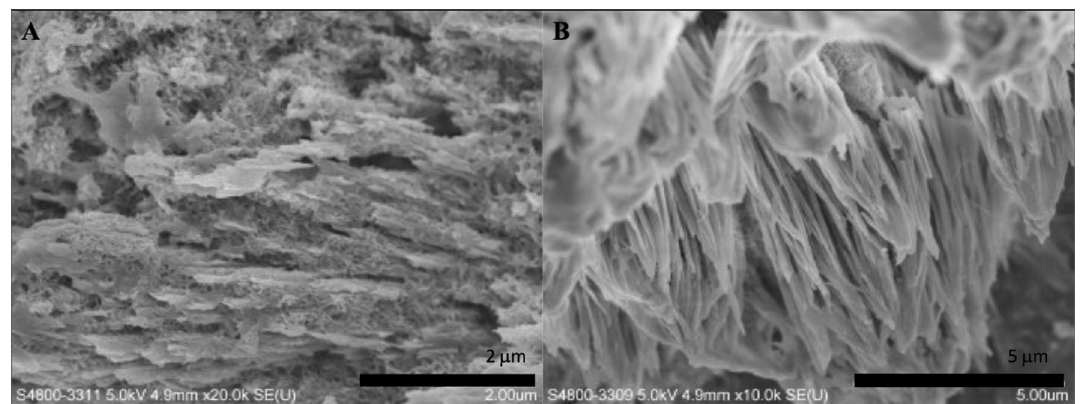
Figure 3. SEM micrographs of the synthesized biomaterial treated with a current of 10 mA, after 10 h mineralization. ( A 20.0 k × magnification; B 10.0 k ×